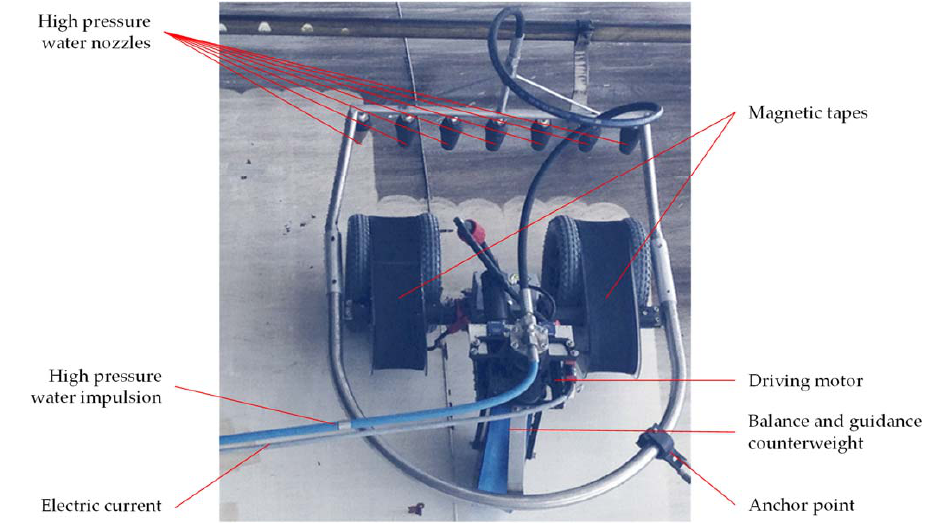
Figure 4. Robotic cleaning process.